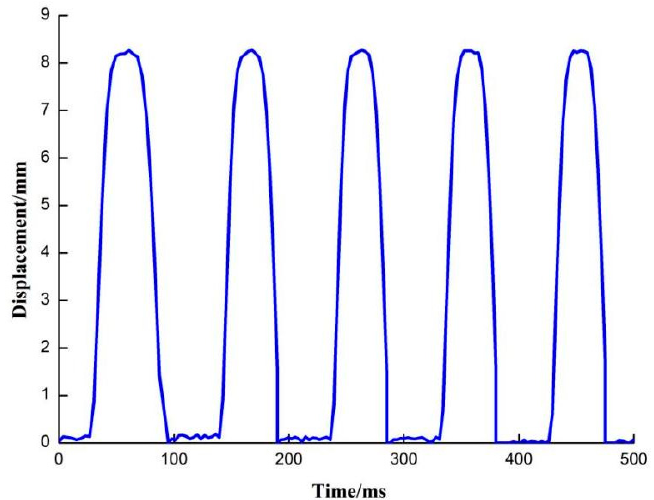
Figure 3. The valve displacement curve obtained from the valve motion